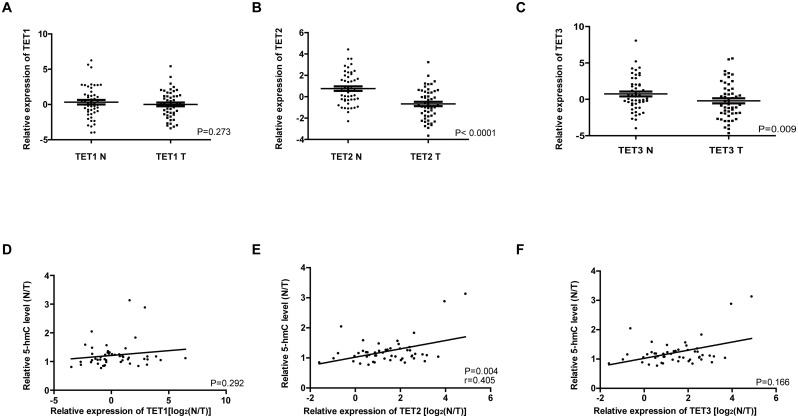
Decreased 5-hmC expression was associated with TET2 downregulation.(A, B and C) TET1/2/3 mRNA levels in 50 matched ESCC tissues and non-tumor tissues were compared. 2−ΔΔCt method was used to calculate the relative expression of TET, and GAPDH was used as an internal control, the sample with the median value of TET1/2/3 among 100 samples were used for normalization. The data were presented on a logarithmic scale. (D, E and F) Associations between TET level and 5-hmC levels in ESCC were analyzed. The relative 5-hmC level were calculated by N/T. The relative TET expression were calculated by 2−ΔΔCt (N-T) and converted to a logarithmic scale on X axis.